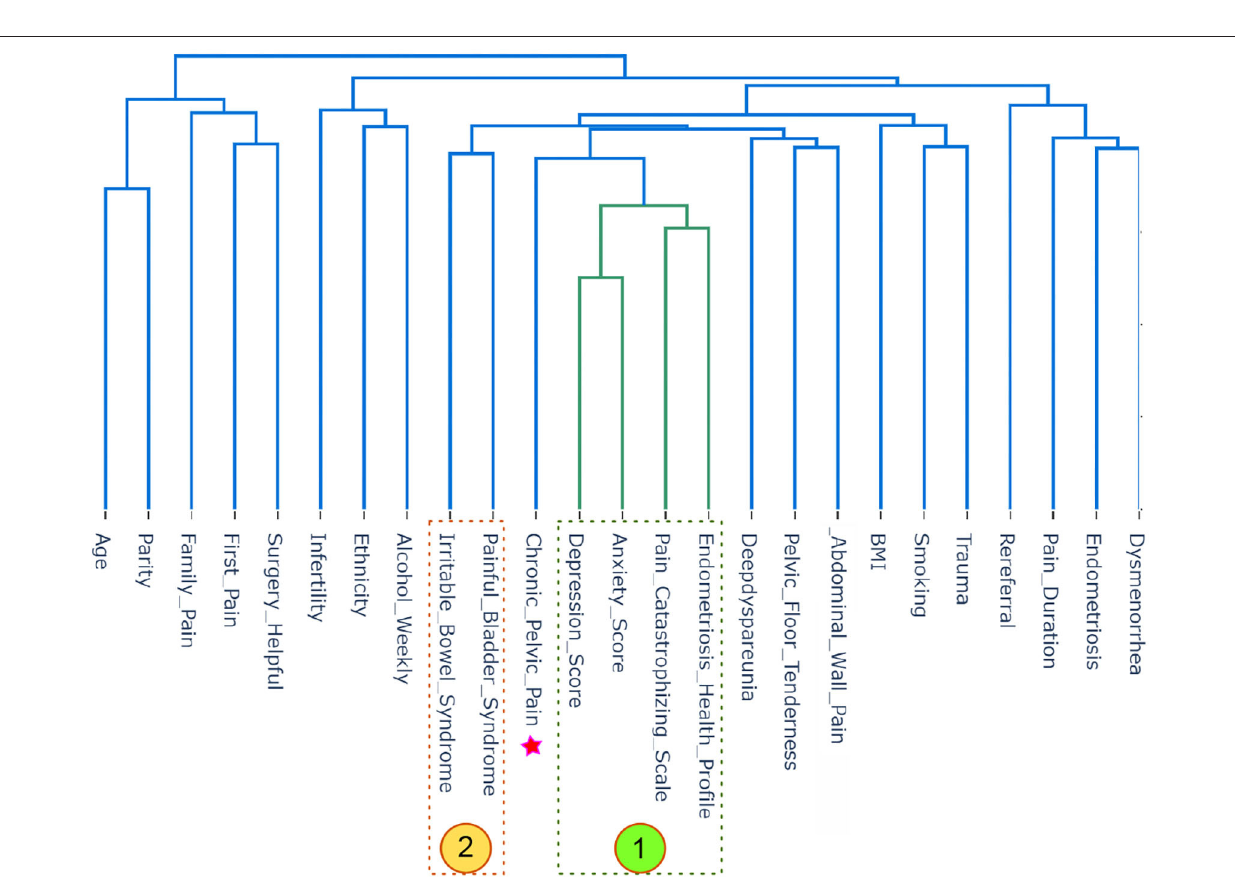
not able to detect a correlation between ethnicity and alcohol (i.e., r = 0.158), ethnicity and infertility (i.e., r = 0.068),